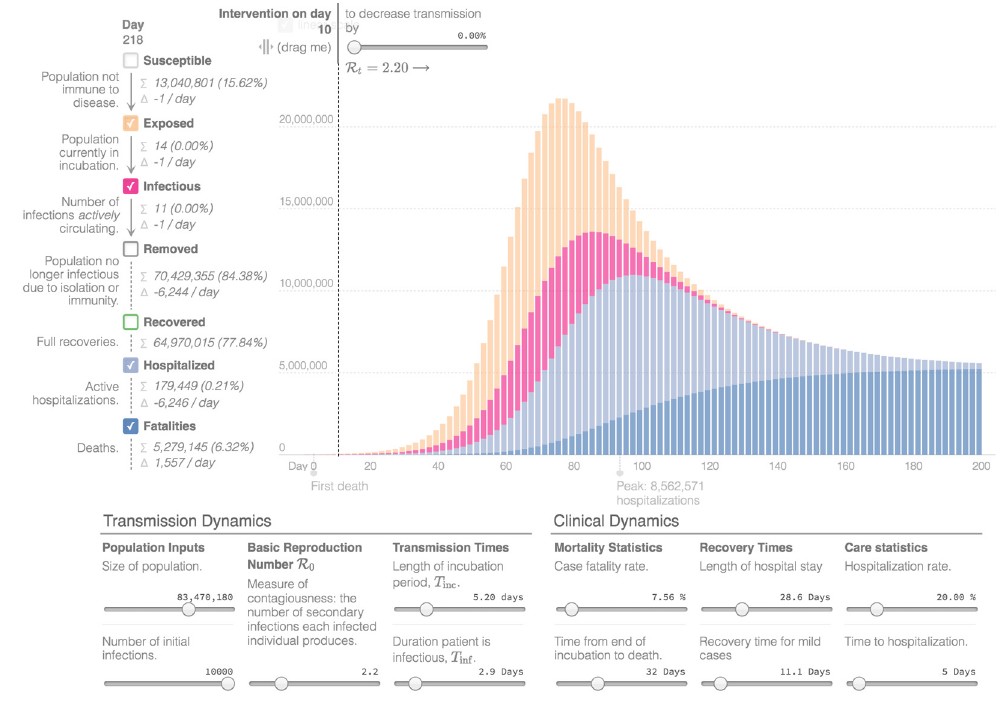
Figure 3. Epidemiological Curve 1 [7].